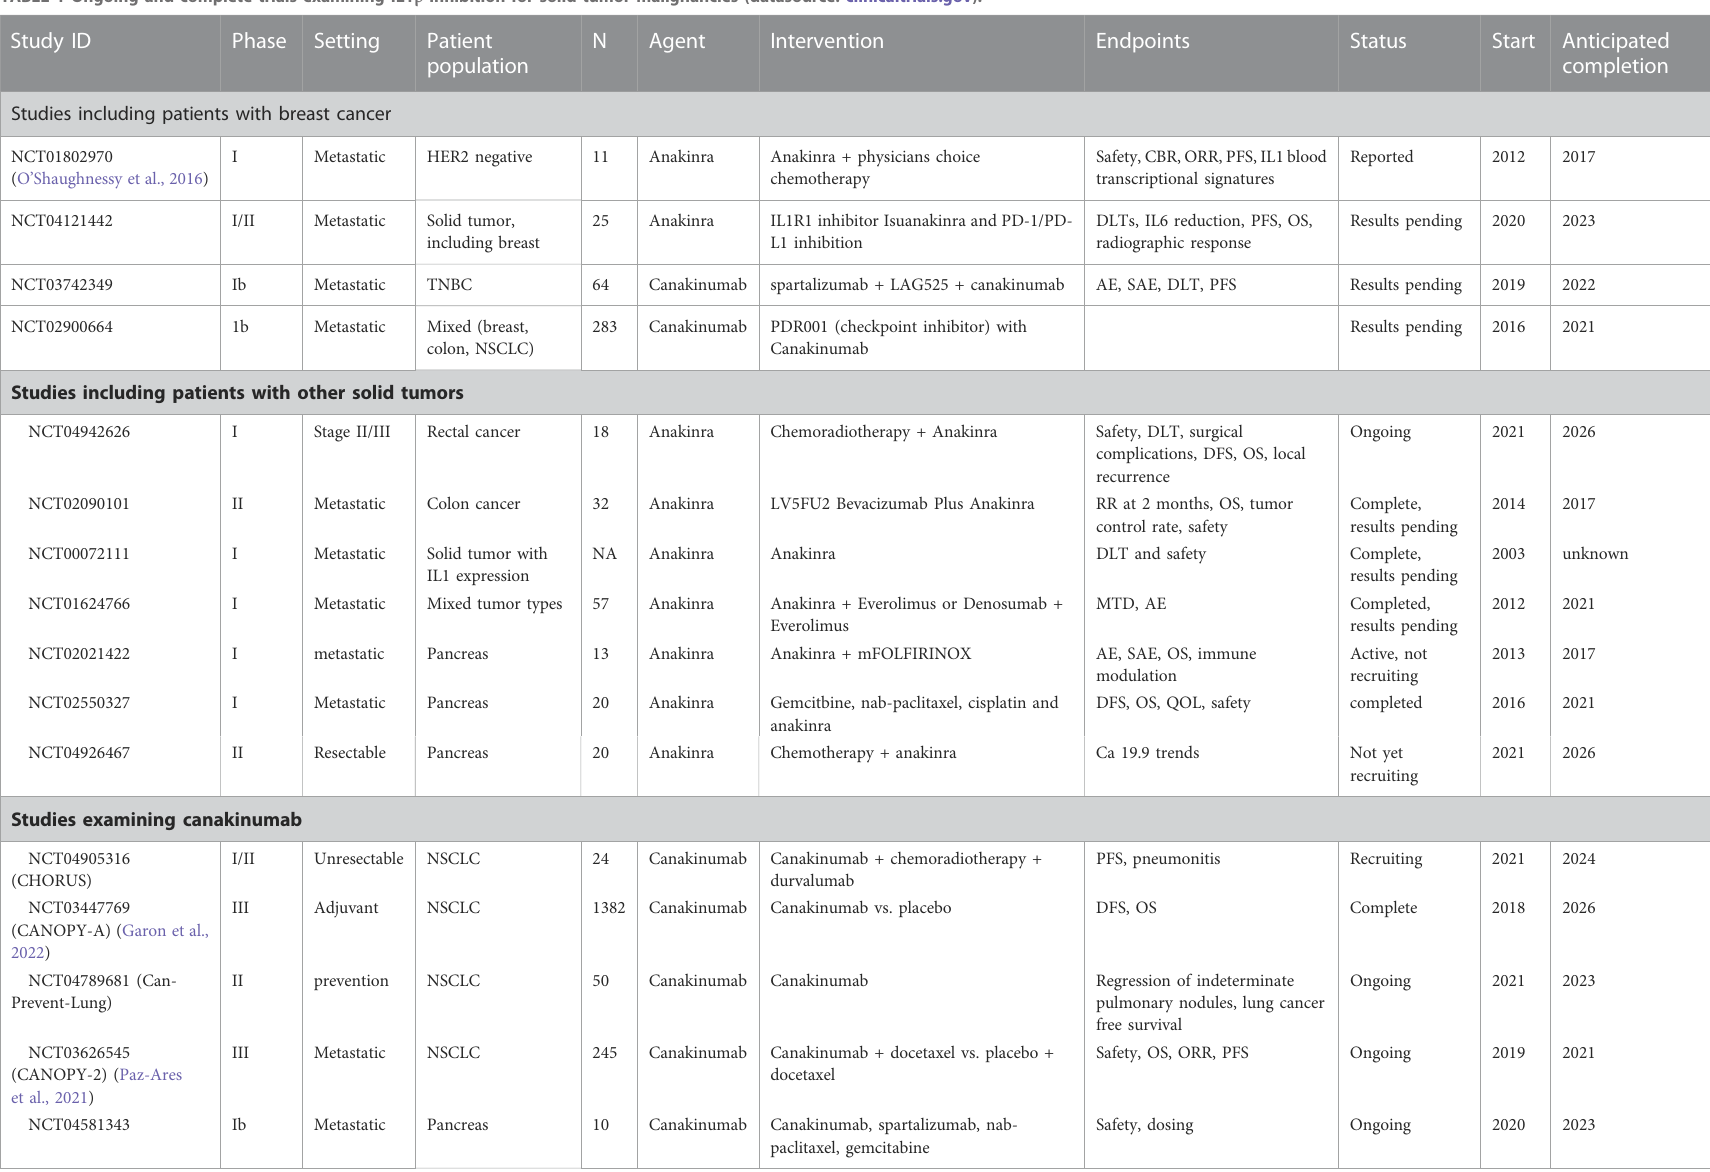
TABLE 1 Ongoing and complete trials examining IL1 β inhibition for solid tumor malignancies (datasource: